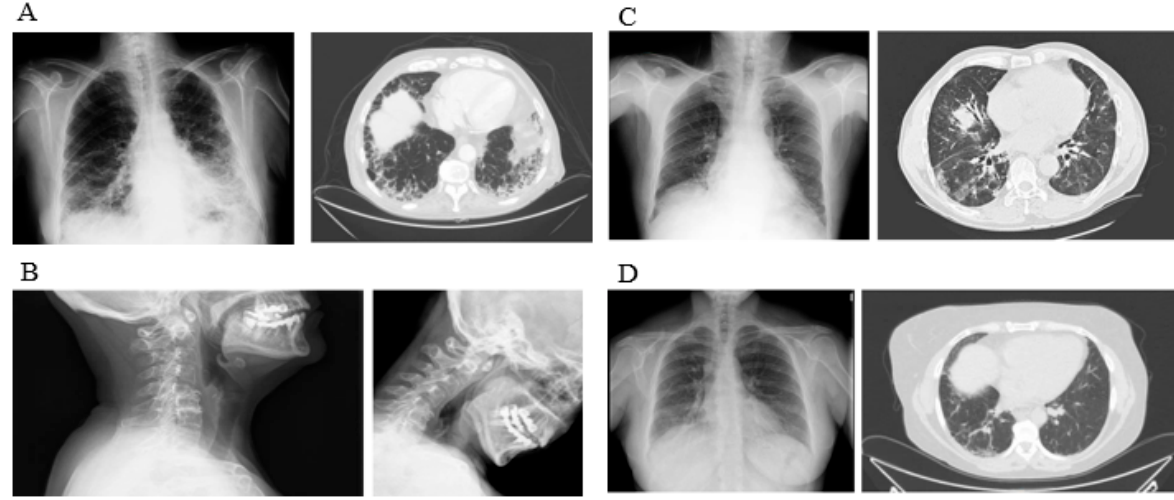
Figure 1. Chest X-ray and high-resolution CT positive for different interstitial lung disease patterns in patients with associated systemic autoimmune disease: ( A ) Pattern usual interstitial pneumonia (UIP) in a patient with rheumatoid arthritis. ( B ) Atlantoaxial subluxation in a patient with interstitial lung disease and rheumatoid arthritis. ( C ) Pattern nonspecific interstitial pneumonia (NSIP) in inflammatory myopathy. ( D ) Pattern nonspecific interstitial pneumonia (NSIP) in systemic sclerosis.